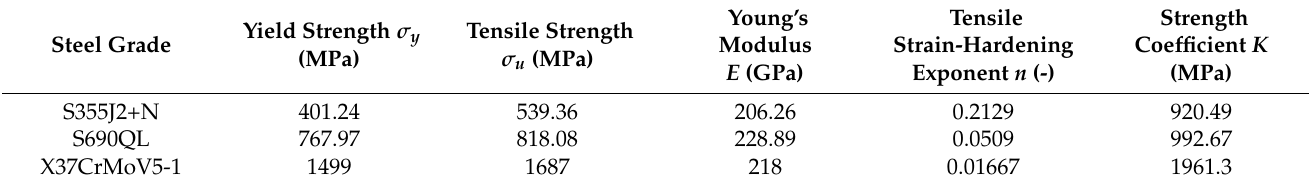
Table 2. Mechanical characteristics of S355J2+N, S690QL, and X37CrMoV5-1.